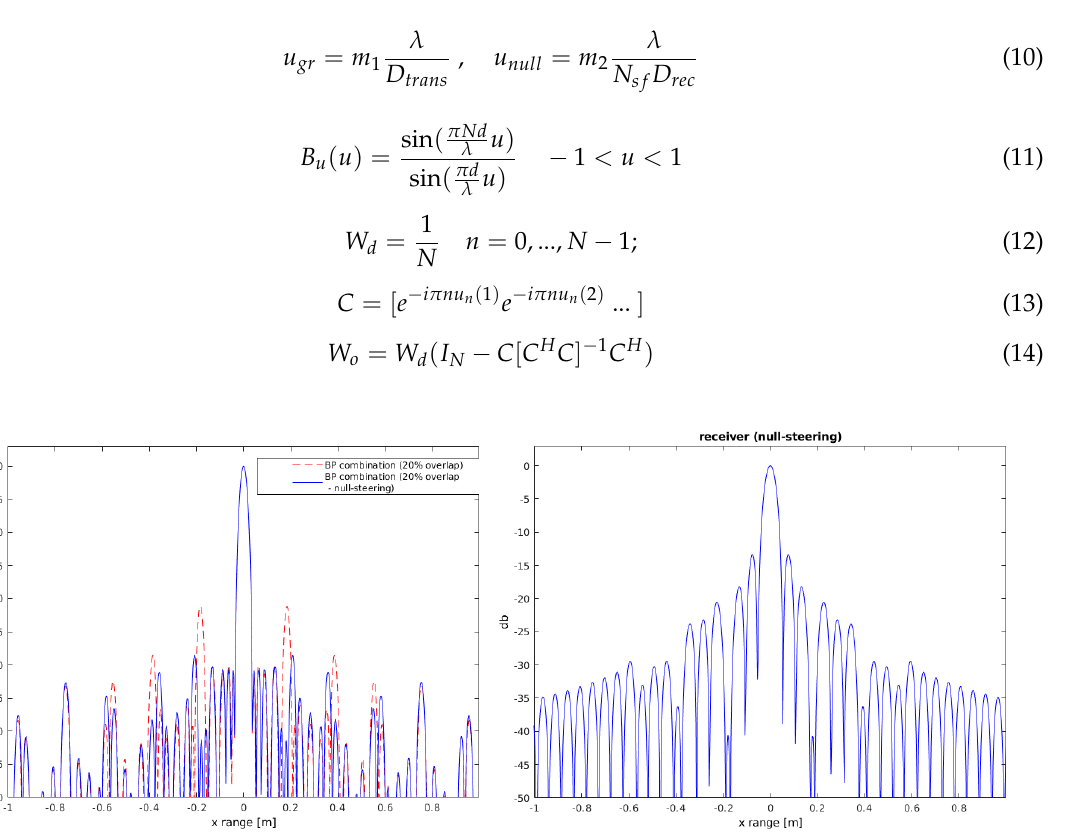
Figure 8. Example null steering suppressing grating lobes occurring with overlap of only